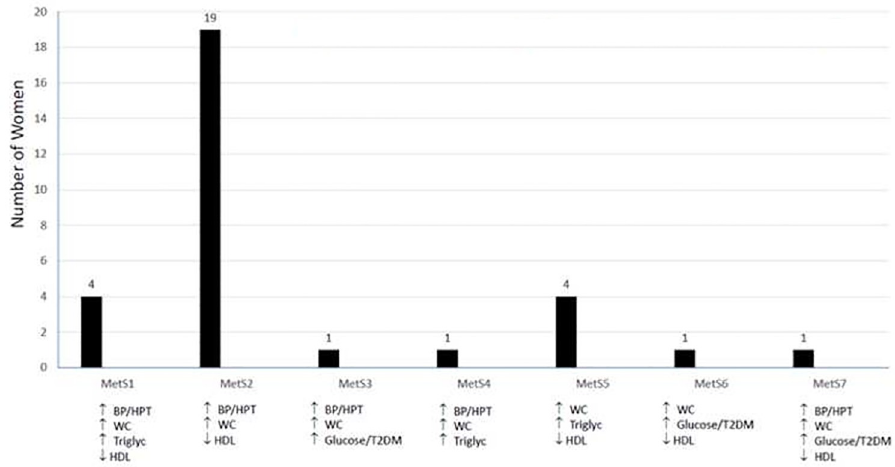
Fig 1. Number of women in the various categories of metabolic